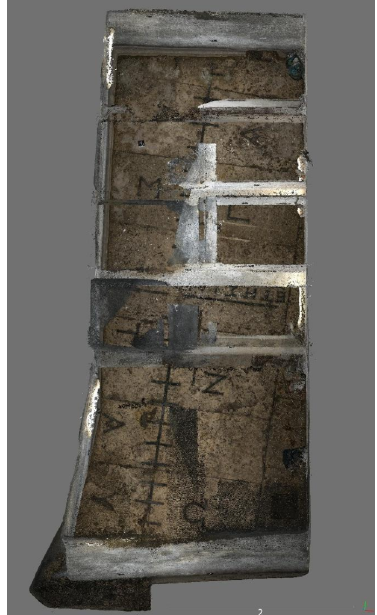
Figure 7. Dense point cloud obtained by photogrammetric survey.